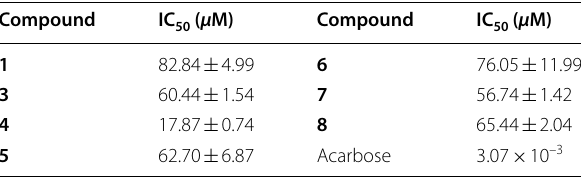
Table 4 Inhibitory effects of compounds 1 and 3 – 8 on α ‑glucosidase (mean ±